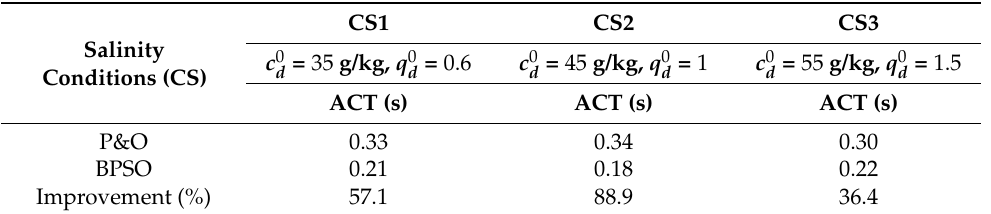
Table 7. Comparative analysis between PSO and BPSO.